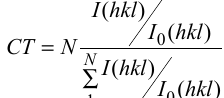
Table 1. Atomic displacements, ∆ x, ∆ y and ∆ z (Å), for the (110) and (101) surfaces.